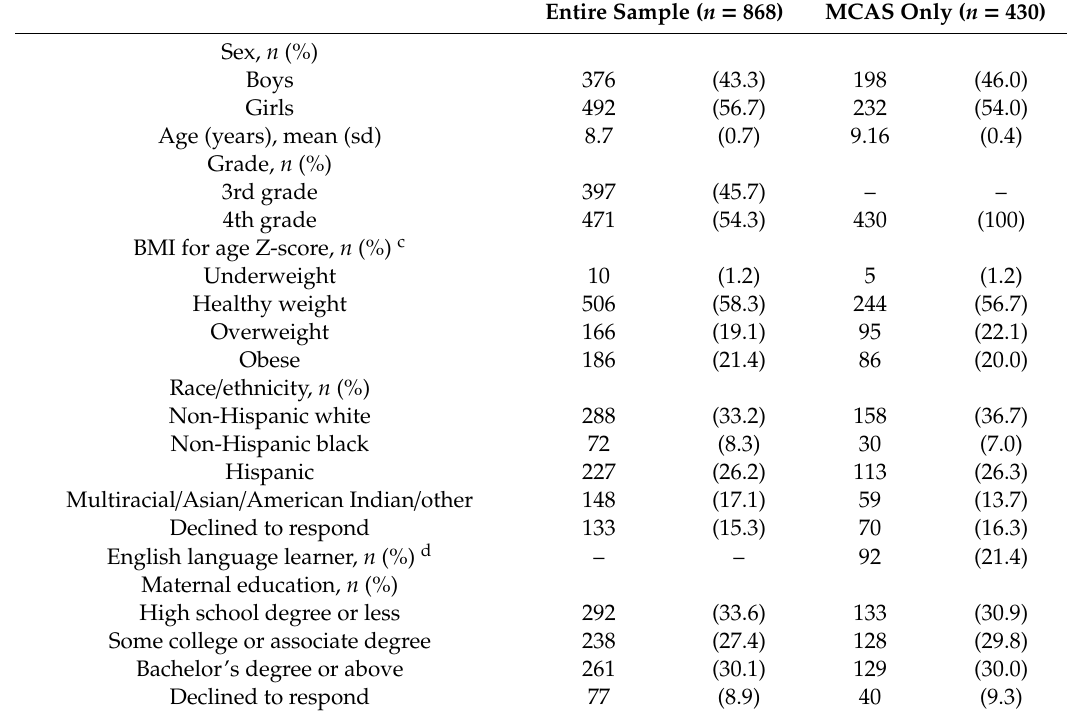
Table 1. Baseline demographic characteristics along with cognitive and standardized test scores (MCAS) a,b of the Fueling Learning Through Exercise study